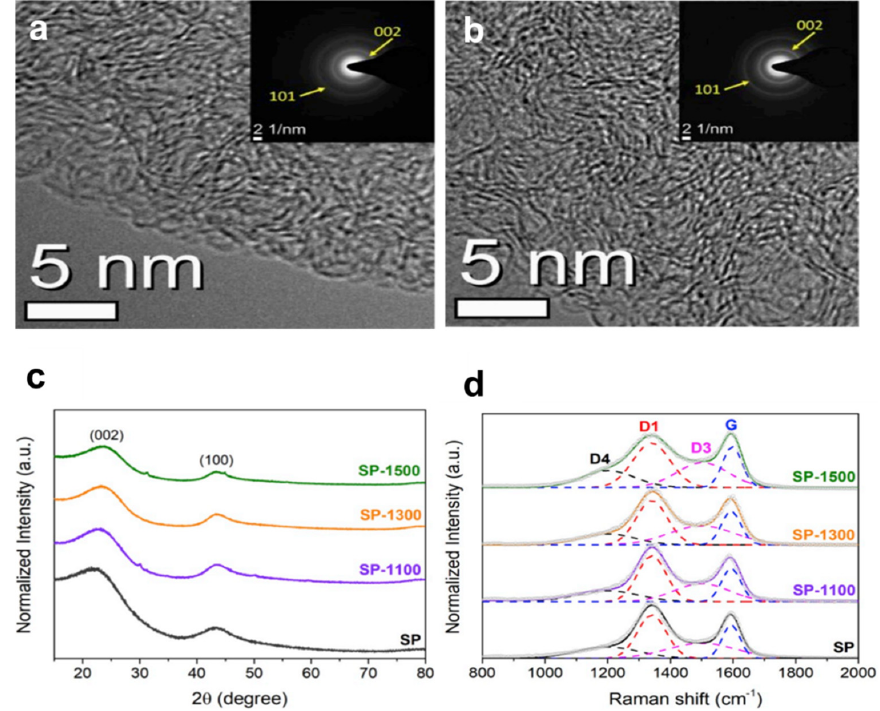
Figure 6. TEM images ( a , b ), XRD patterns ( c ) and Raman spectra ( d ) of hard carbons derived from fir wood. Reprinted with permission from Ref. [105]. Copyright 2019 Elsevier.